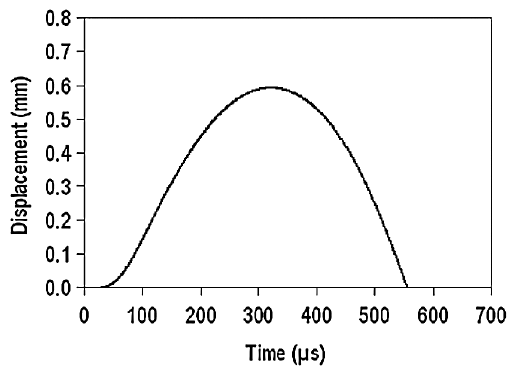
FIG. 5. Calculated motion of flyer plate.